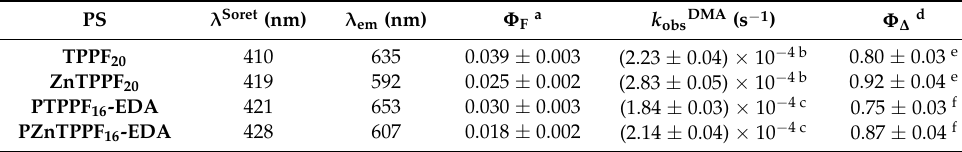
Table 1. Spectroscopic and photodynamic properties of PSs in DMF.